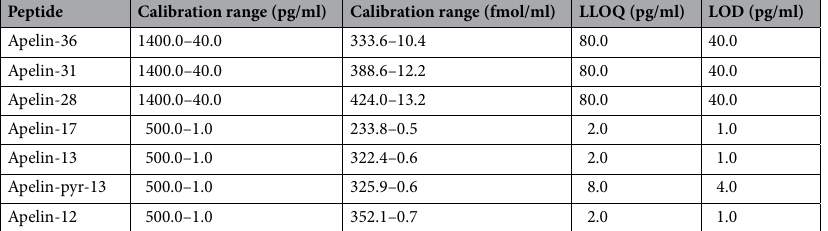
Table 6. Calibration curves